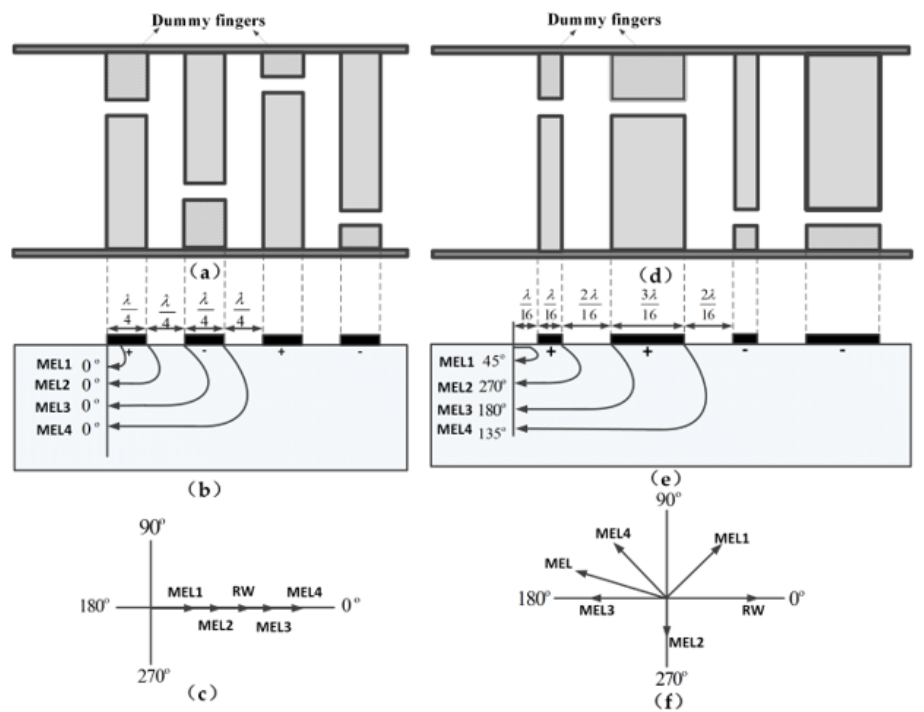
Figure 2. Electrode reflection of single electrodes IDTs and unbalanced-split-electrode IDTs. ( a ) Single electrodes IDTs; ( b ) Mass load (MEL) reflection of single electrodes IDTs; ( c ) Phase synthesis diagram of single electrodes IDTs; ( d ) Unbalanced-split electrodes IDTs; ( e ) Mass load (MEL) reflection of unbalanced-split electrodes IDTs; ( f ) Phase synthesis diagram of unbalanced-split electrodes IDTs. Table 1. Piezoelectric substrate materials and their 𝑘 (cid:2870) .